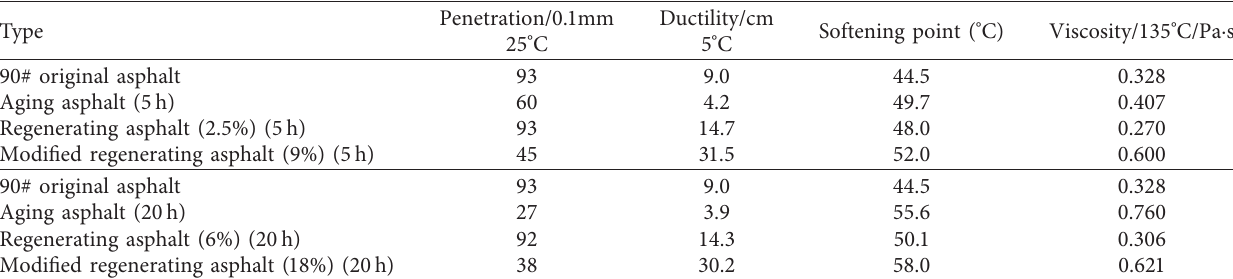
Table 9: Indexes of first regeneration and then modification of aging